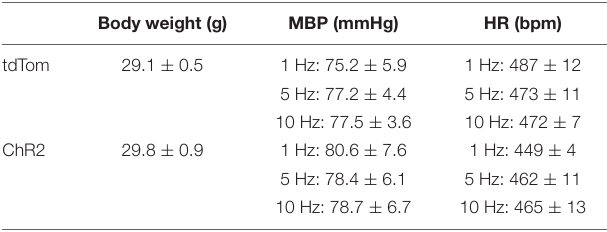
TABLE 1 | Body weights, baseline mean blood pressure (MBP), and heart rate (HR) prior to optogenetic